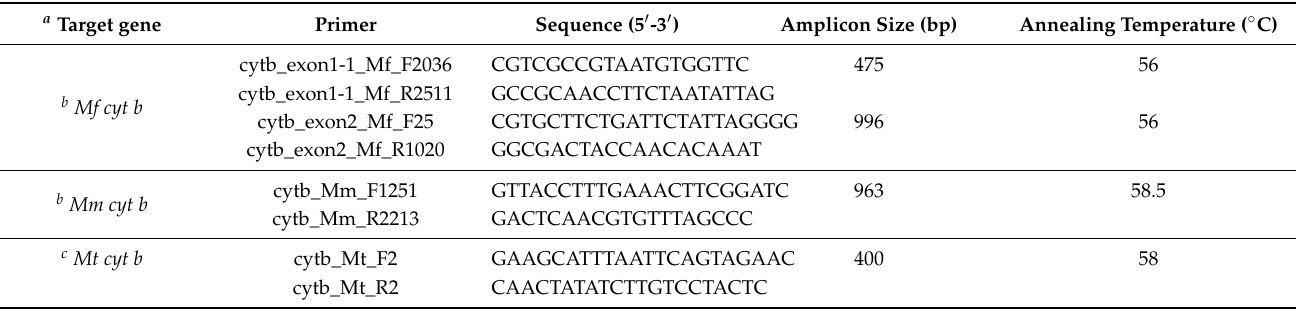
Table 1. Specific primers for PCR amplifications, and to evaluate the variation at the cyt b gene in Mycosphaerella fijiensis , M. musicola and M. thailandica